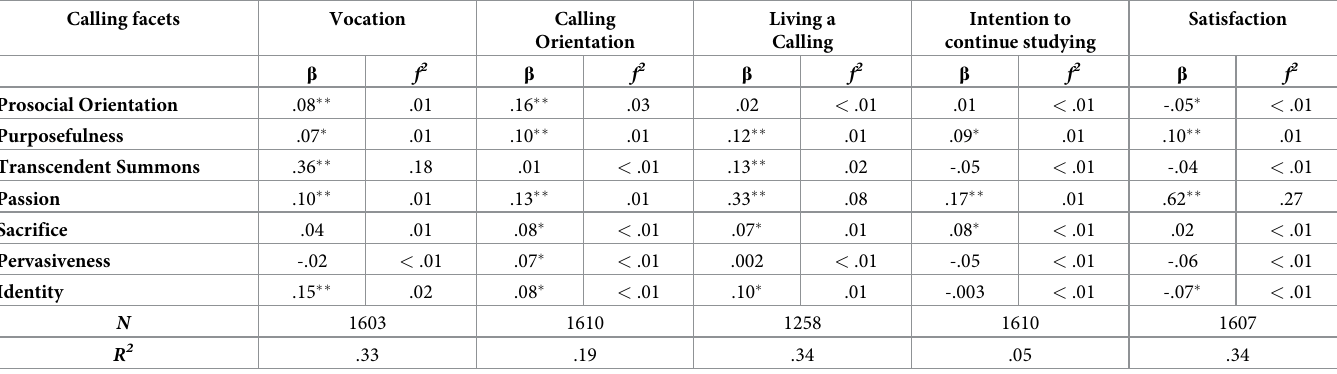
Table 5. External validity